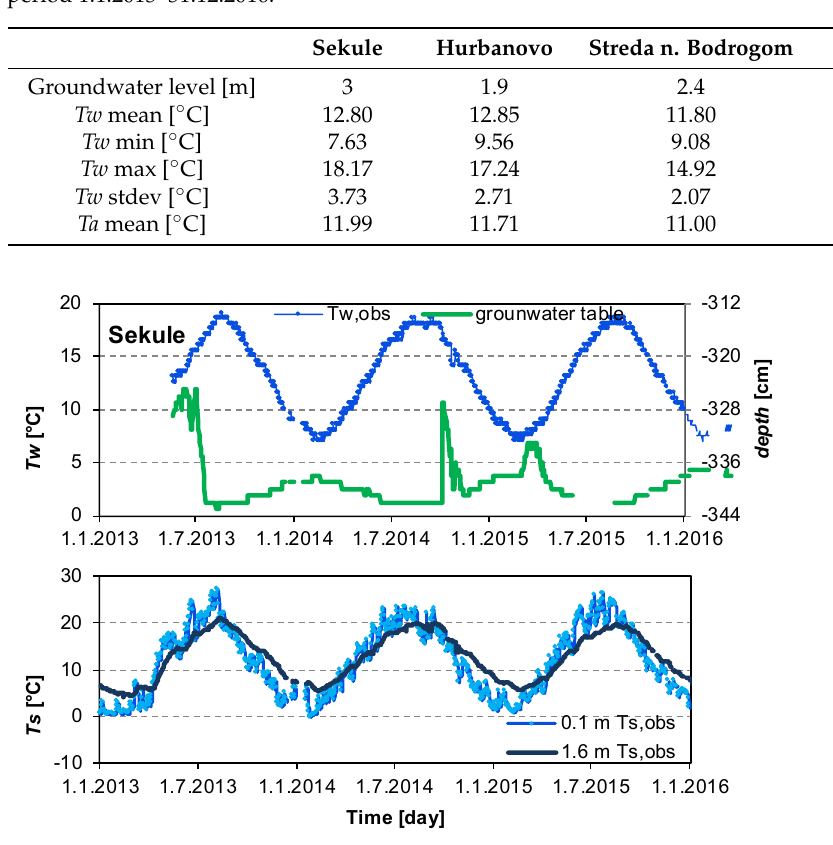
Figure 5. Daily measured soil Ts , groundwater temperature Tw , and depth of the groundwater table at the Sekule station during the period 2013–2016 (data measured at 7 am).